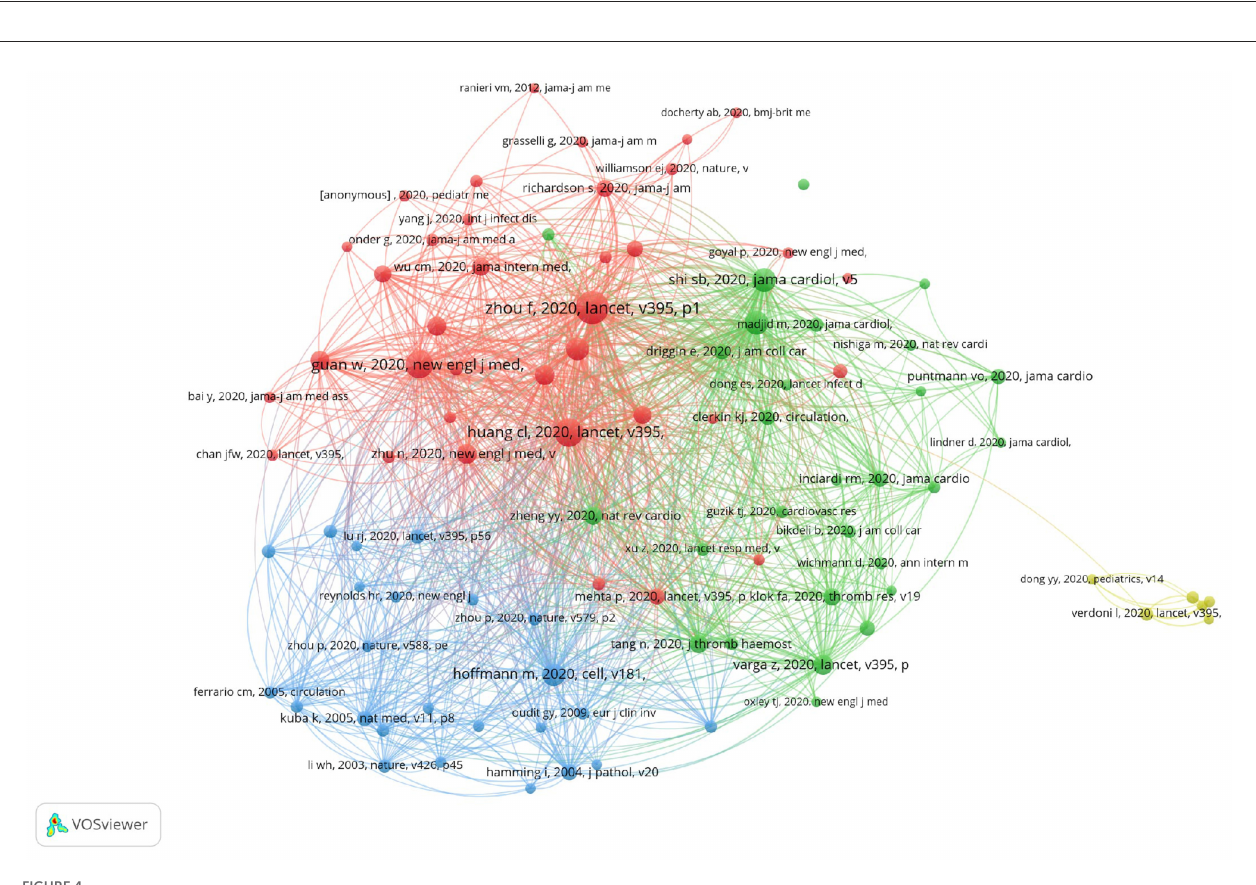
FIGURE4 VOSviewer network visualization map of references to COVID-19-related CVD